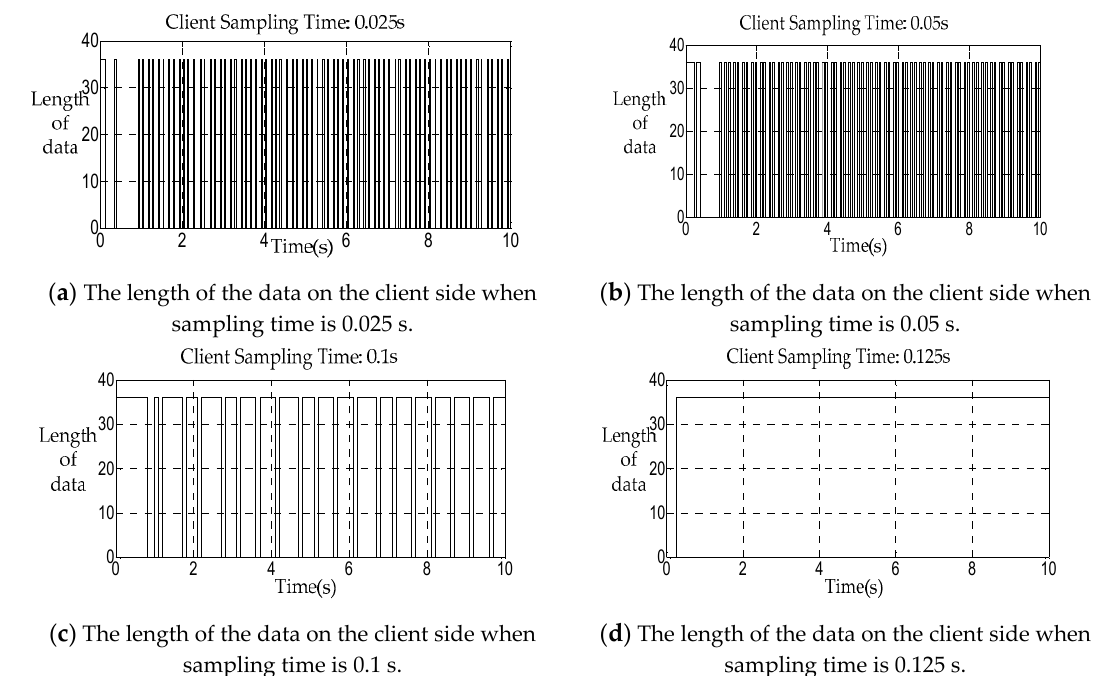
Figure 10 . Communication frequency test before simulation. Figure 10. Communication frequency test before simulation.